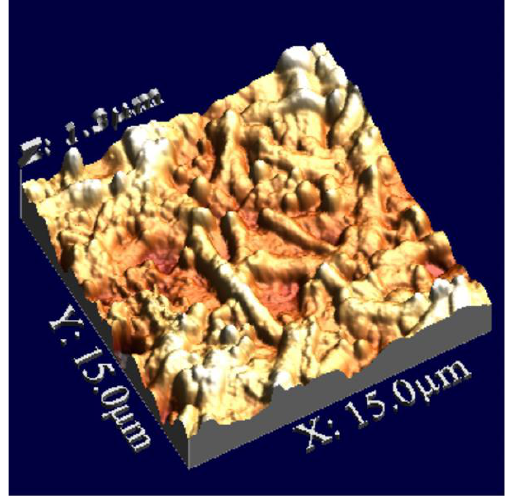
Figure 3. AFM measurements (contact mode) of E. coli strain W assembled on sensor layers.